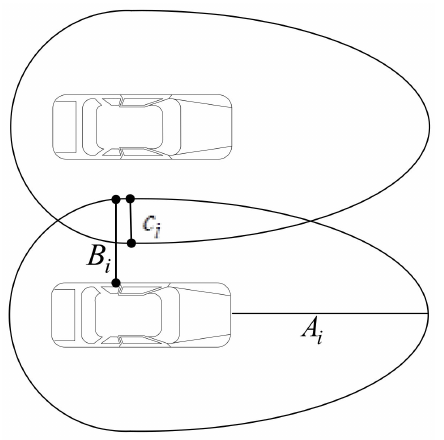
Figure 4. Schematic diagram of intrusion